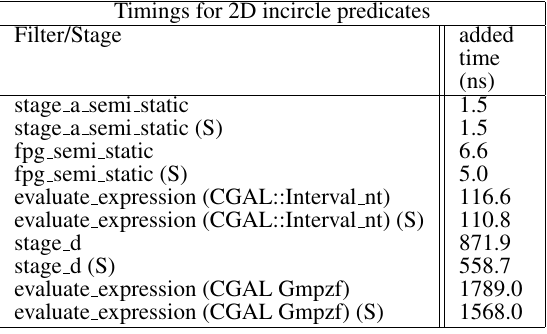
Table 4. Time added by a filter over a non-robust 2D incircle implementation during the computation of a Delaunay triangulation of uniformly distributed points. Figure 3. Performance times for the construction of the Delaunay triangulation of three datasets. Timings in ms.